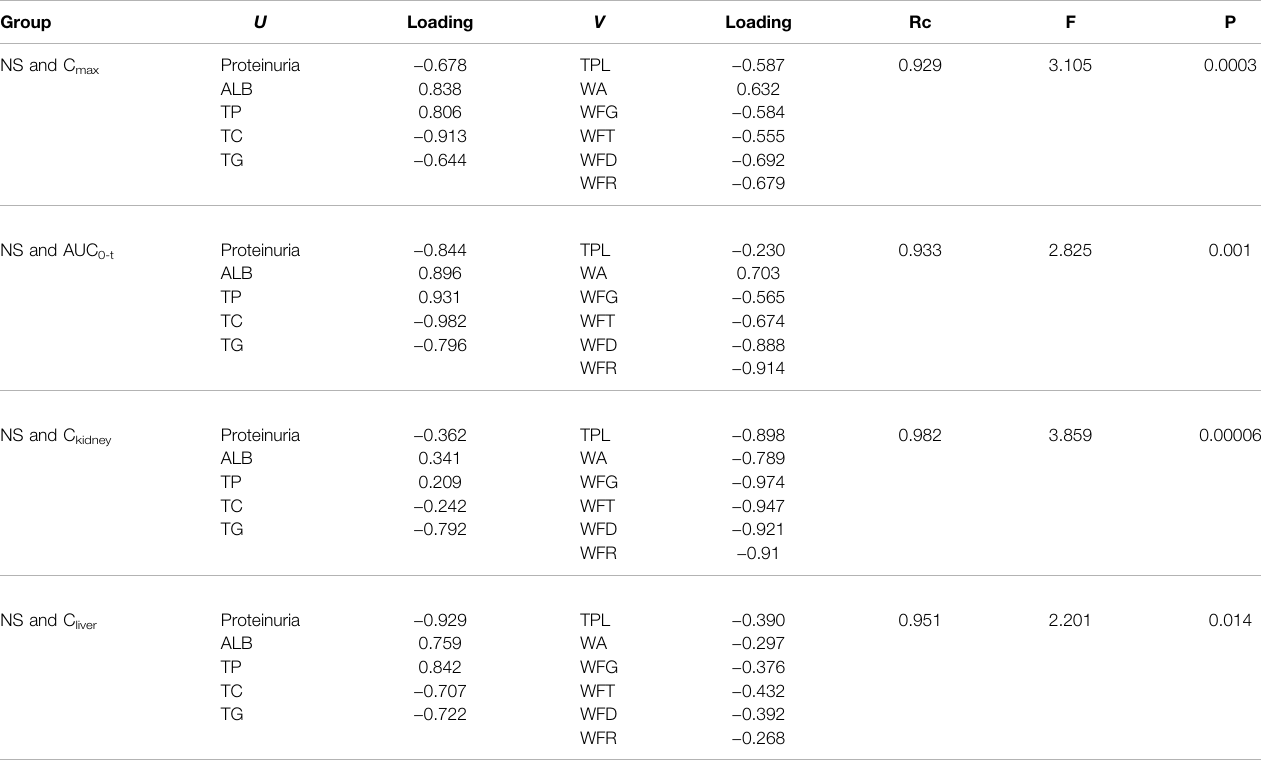
TABLE 2 | Canonical structures of the fi rst pair of canonical variables between the severity of NS and in vivo exposure of six key TGT key components ( n = 7).